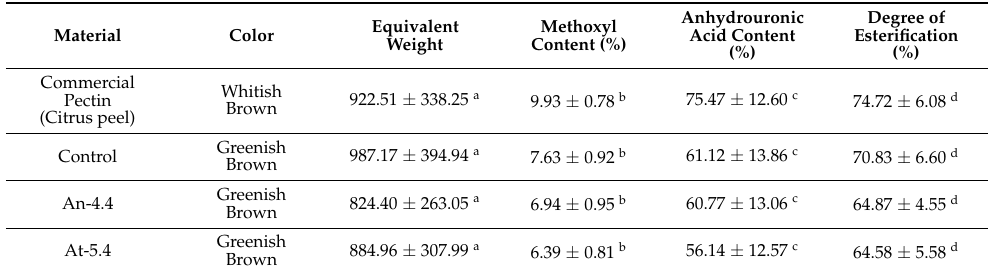
Table 1. Characterization of pectin at different biochemical parameters isolated from transgenic and control